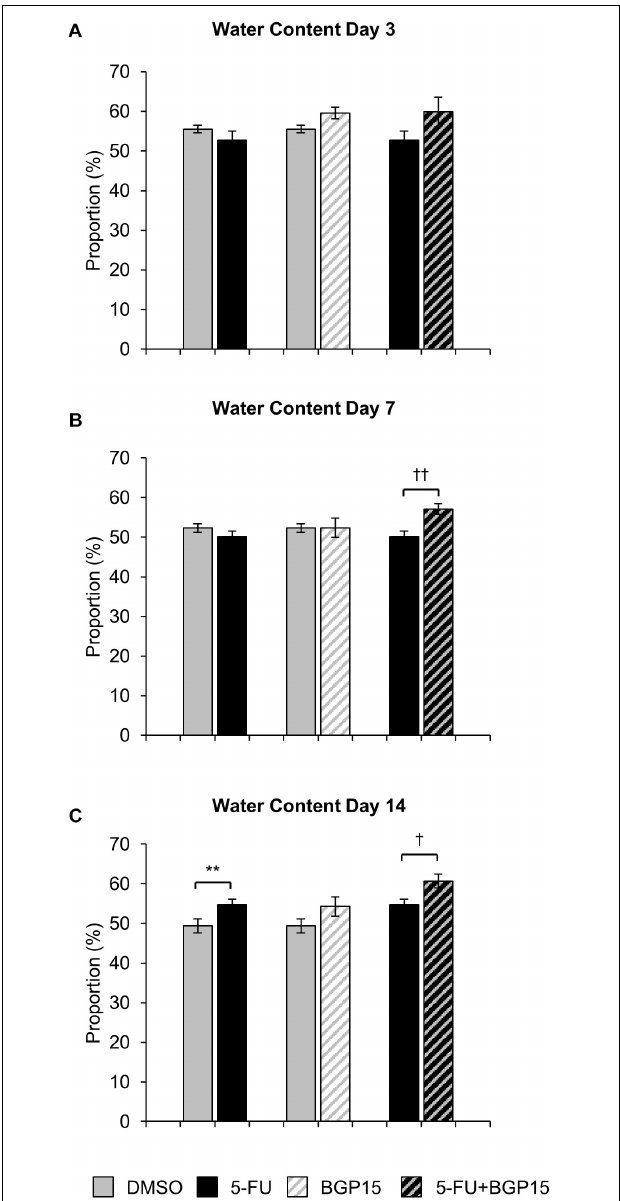
FIGURE 2 | Water content following in vivo 5-FU ± BGP-15 administration. Fecal water content calculated as the difference between the wet weight and dry weight following 3 days (A) , 7 days (B) , and 14 days (C) treatment with DMSO, 5-FU, BGP-15, and 5-FU+BGP-15 treatment. Data represented as mean ± SEM. ∗∗ P < 0.01 significantly different to DMSO group. † P < 0.05, †† P < 0.01, significantly different to 5-FU ( n = 5